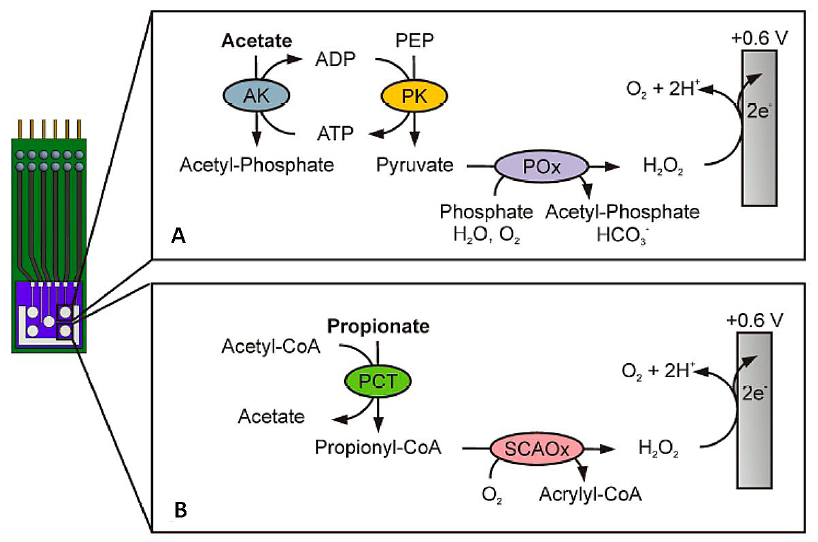
Figure 2. Amperometric detection principles of ( A ) an acetate biosensor using acetate kinase (AK), pyruvate kinase (PK), and pyruvate oxidase (POx), and ( B ) a propionate biosensor using propionate CoA-transferase (PCT) and short-chain acyl-CoA oxidase (SCAOx). Adapted from [34] with permis- sion.